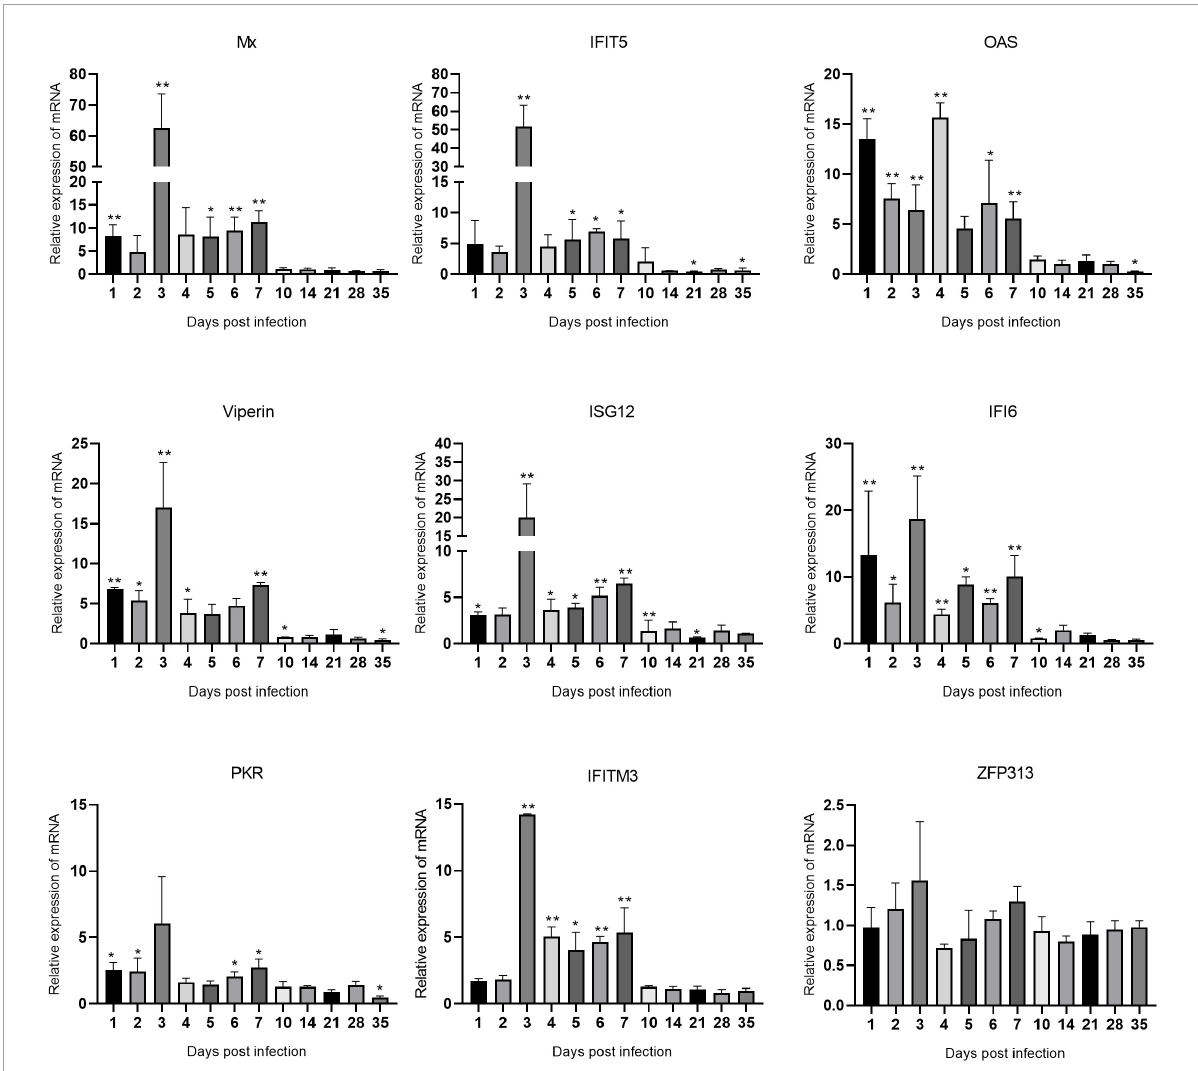
FIGURE7 Changes in ISG transcription levels in the thymus after ARV infection. ARV strain S1133 (10 4 TCID 50 /0.1 ml) was used to infect chickens through the footpad. At 1, 2, 3, 4, 5, 6, 7, 10, 14, 21, 28, and 35 days after infection (dpi), three chickens were randomly collected from each group, and changes in ISG mRNA levels in the thymus were measured by real-time quantitative PCR. The data are the mean ± SD of three independent experiments. Asterisks indicate significant differences (* P < 0.05, ** P <